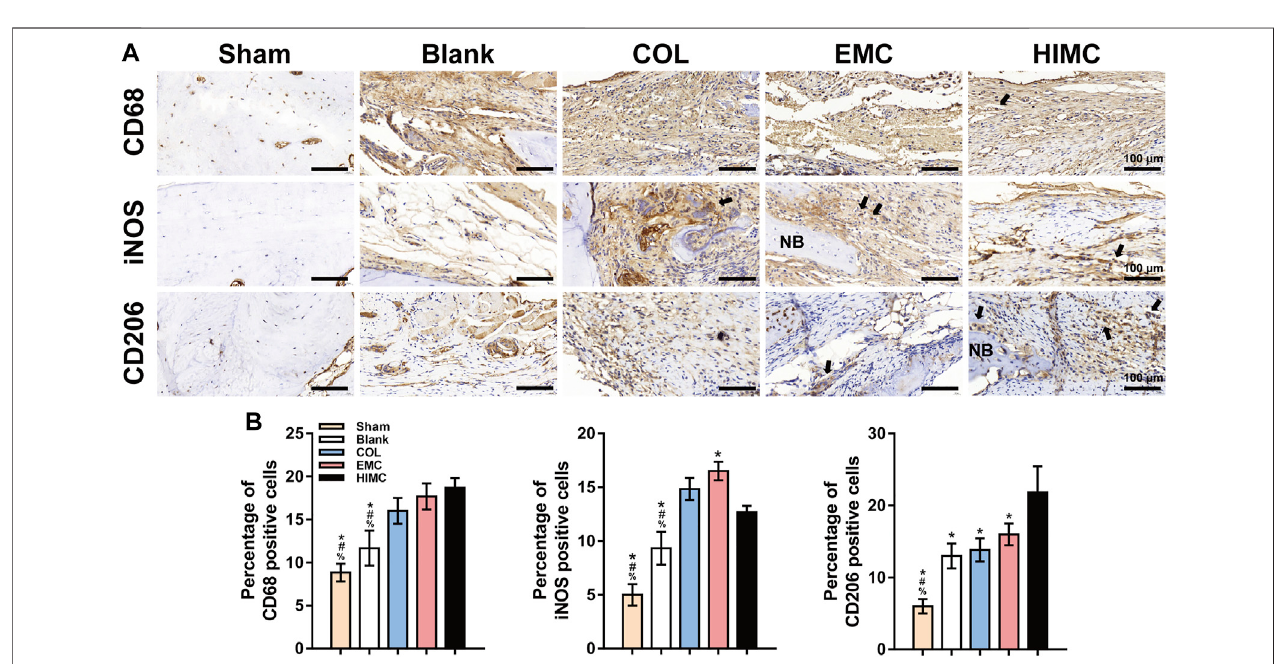
FIGURE7| IHCstainingformacrophagepolarizationmarkersinthedefectregionofdifferentgroupsat2 weekspost-surgery.Positivelystainedcellsareindicated byarrows. (A) PanmarkerCD68,M1markeriNOS,and M2markerCD206expressionindefect tissues. (B) Semi-quanti fi cationofthepositivecells.Dataareexpressed as mean ± SD. Scale bar, 100 μ m. * p < 0.05 vs. HIMC membrane; # p < 0.05 vs. EMC membrane; % p < 0.05 vs. COL membrane.